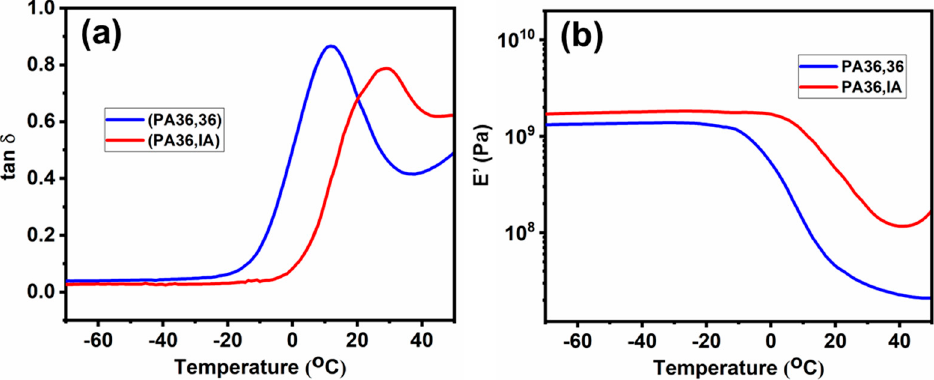
Figure 5. DMA traces of the prepared bio ‐ based PAs: ( a ) tan δ and ( b ) storage modulus.